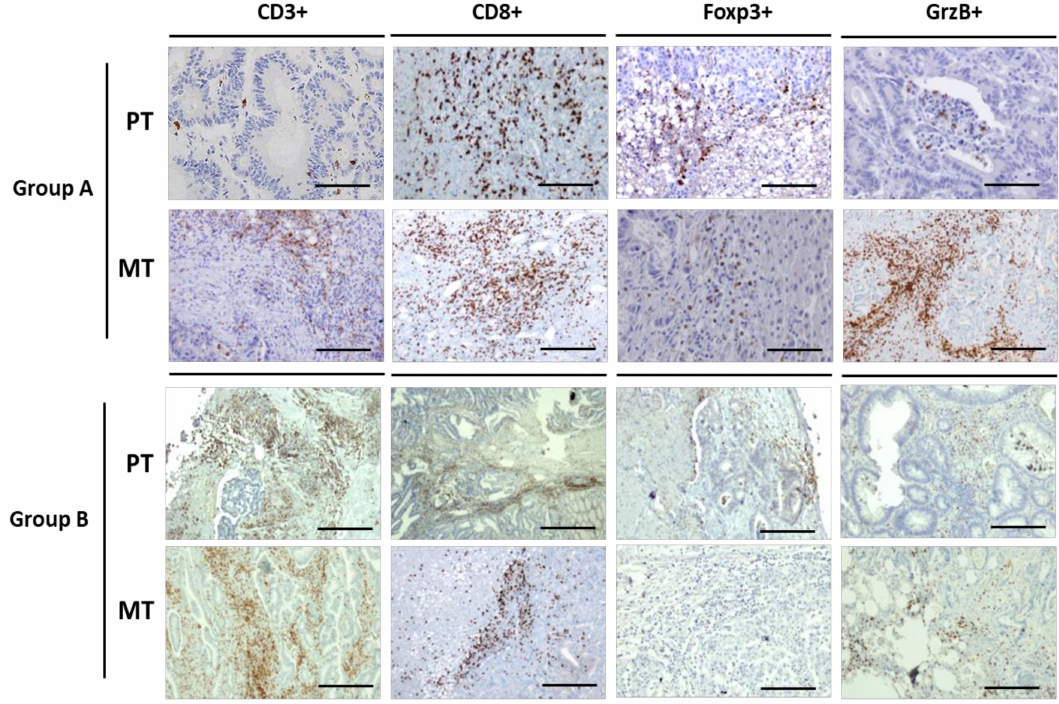
Figure 4. Representative immunohistochemistry of CD3, CD8, Foxp3 and GrzB + cells (bar = 200 µ